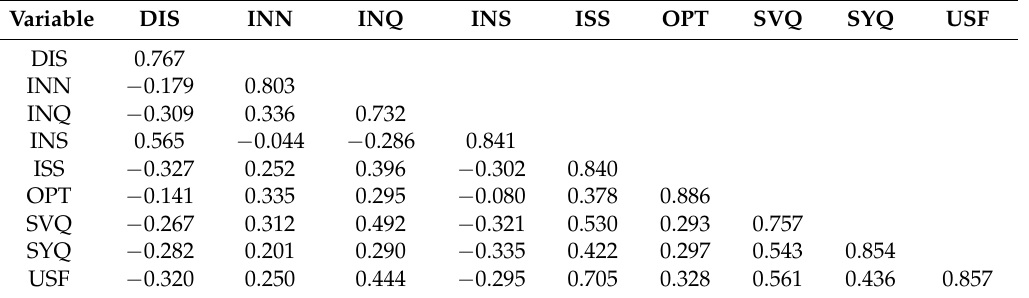
Table 6. Fornell and Larcker’s [71] square root